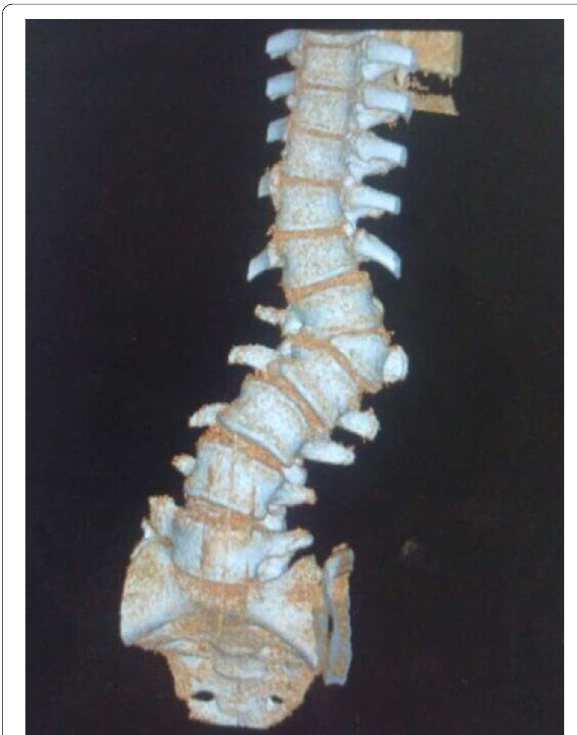
Fig. 1 CT scan with 3 D reconstruction showing a case of congenital scoliosis in 14-year-old female patient. A congenital hemivertebra is found at the level of L1–L2 (lumbar